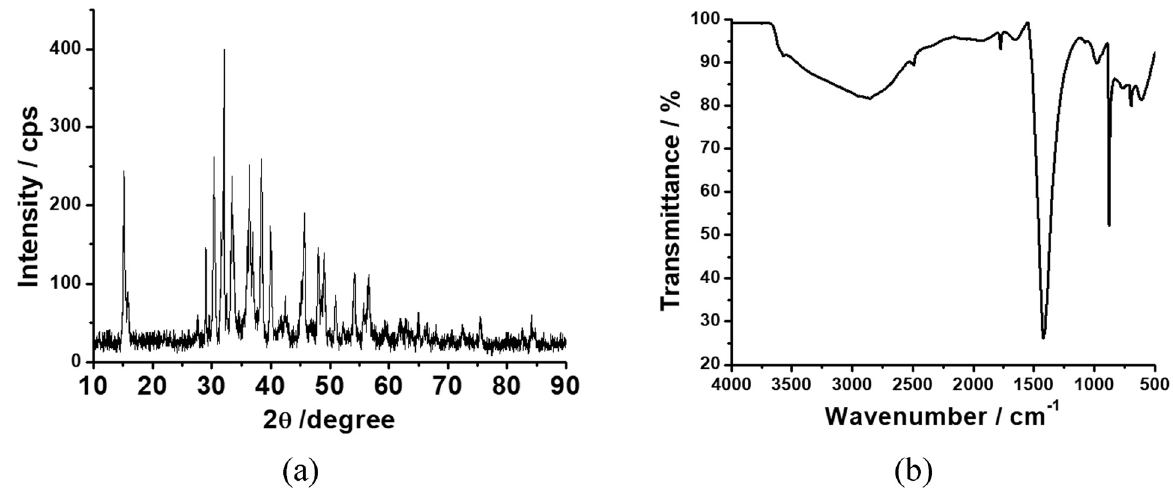
Figure 9: XRD ( a ) and FTIR spectra ( b ) of ferrate.